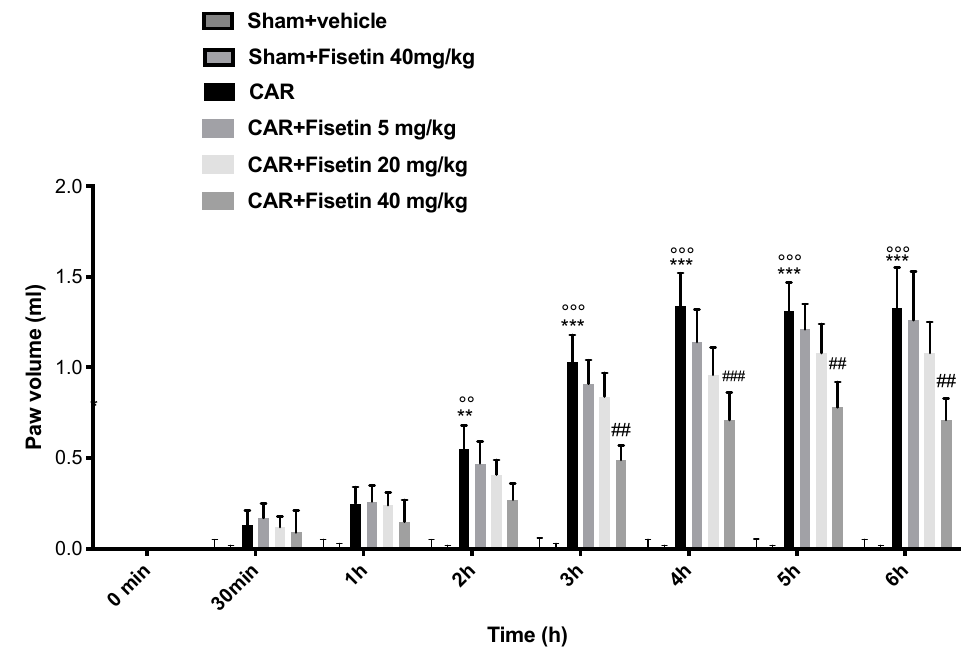
Figure 1. Preliminary data of anti-inflammatory effects of Fisetin on CAR-induced paw edema on different doses. The animals were treated at different doses, respectively, 5, 20, and 40 mg/kg. Values are means ± SEM of 6 animals for each group; *** p < 0.001 vs. sham + vehicle. ** p < 0.01 vs. sham + vehicle, ◦◦◦ p < 0.001 vs. sham + Fisetin 40 mg/kg, ◦◦ p < 0.01 vs. sham + Fisetin 40 mg/kg. ### p < 0.001 vs. CAR. ## p < 0.01 vs.